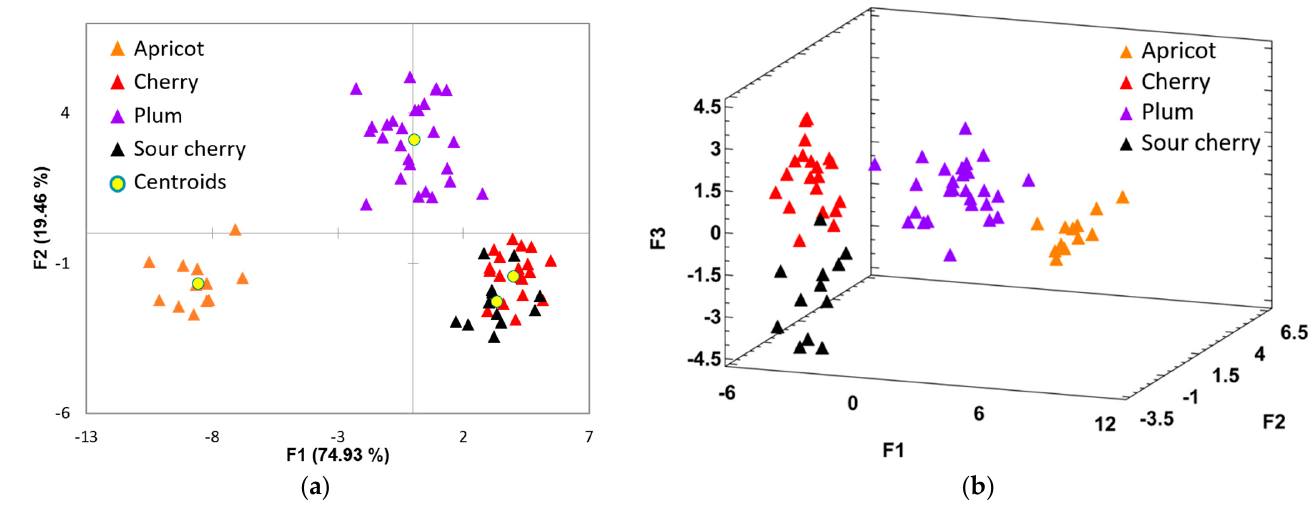
Figure 4. ( a ) 2D and ( b ) 3D plots showing the discrimination of fruit juices samples according to their botanical origin. botanical